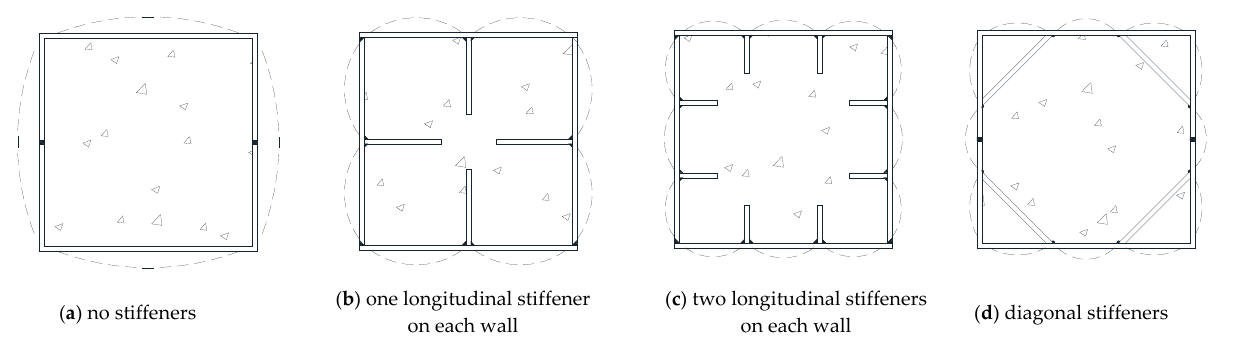
Figure 1. Typical buckling mode of CFST with different stiffeners.